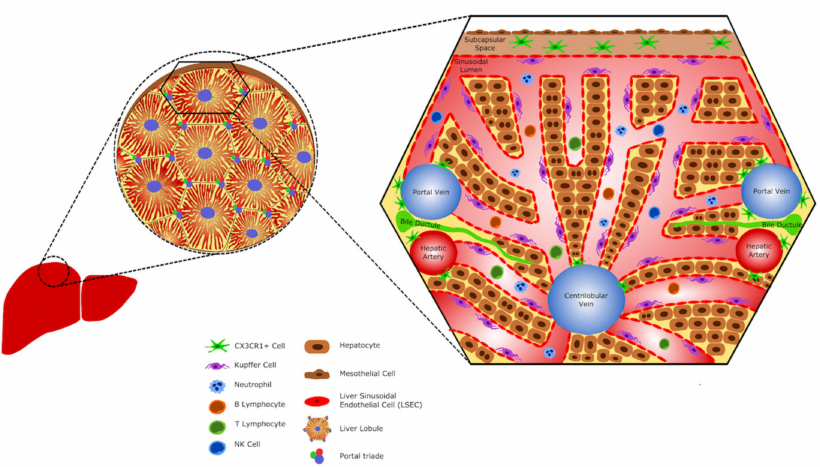
Figure 1. The hepatic immune cells. Schematic representation showing hepatic cells and their location. The liver harbors a large population of immune cells. Dendritic cells (CX3CR1 + cells) can be found in the subcapsular space and surround large vessels, as the centrilobular vein and the portal triade vessels (portal vein and hepatic artery). Kupffer cells are the liver resident macrophages and constitute the largest population of hepatic immune cells. They can be found within sinusoids, in contact with endothelial cells. Neutrophils, B lymphocytes, T lymphocytes, and NK cells eventually circulate in the